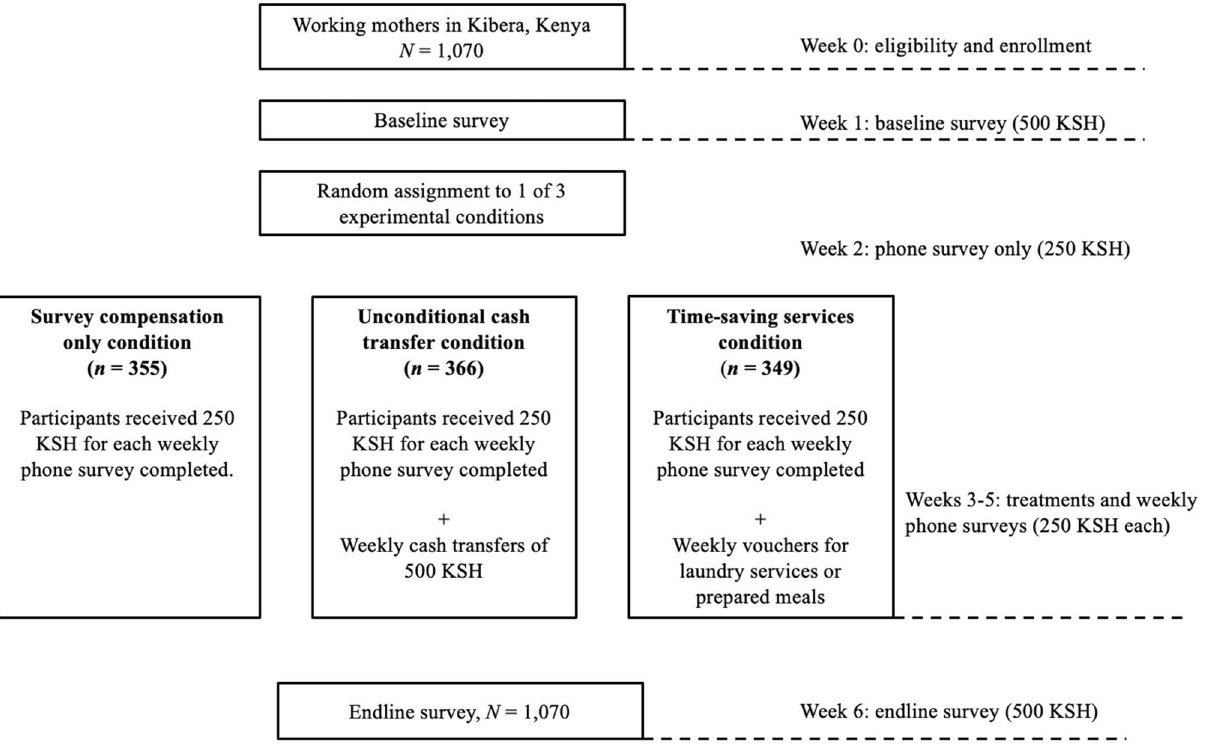
Figure 3. Overview of study design and